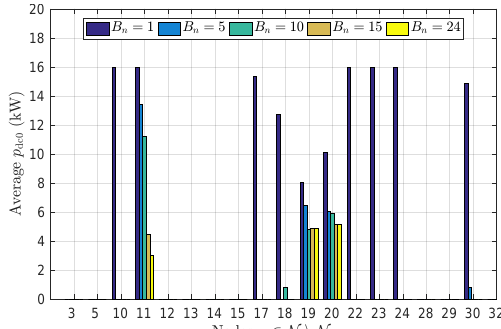
Figure 9. Average nameplate DC rating of the PV module.